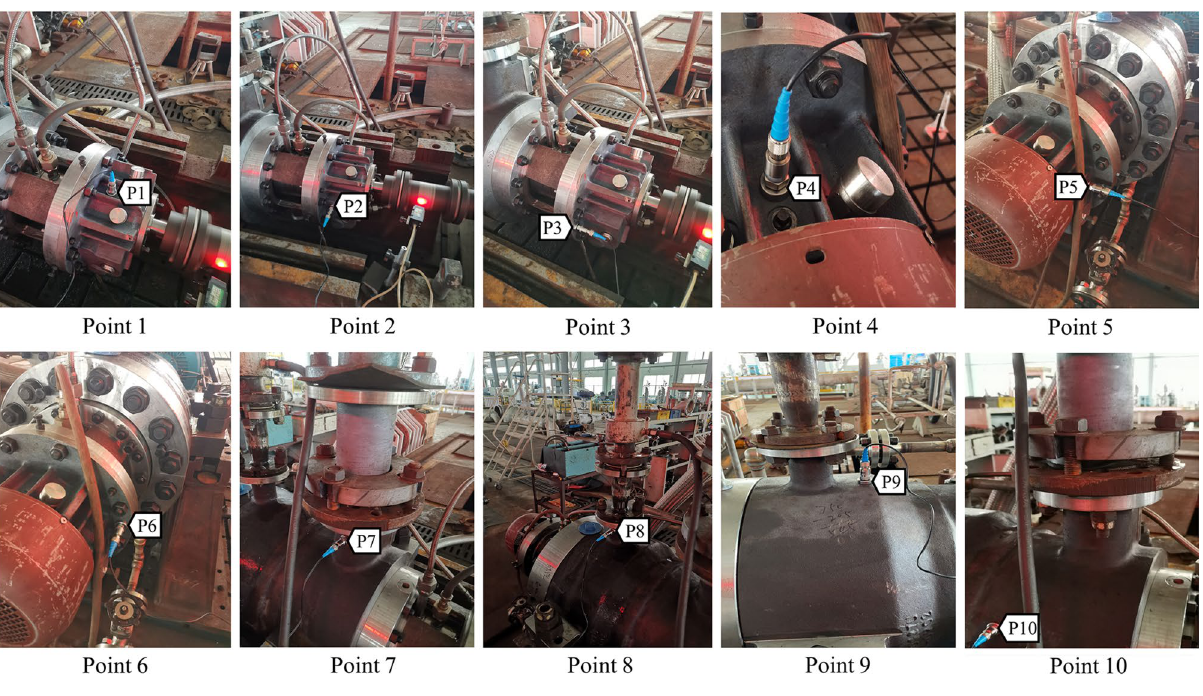
Figure 9. Arrangement of measuring